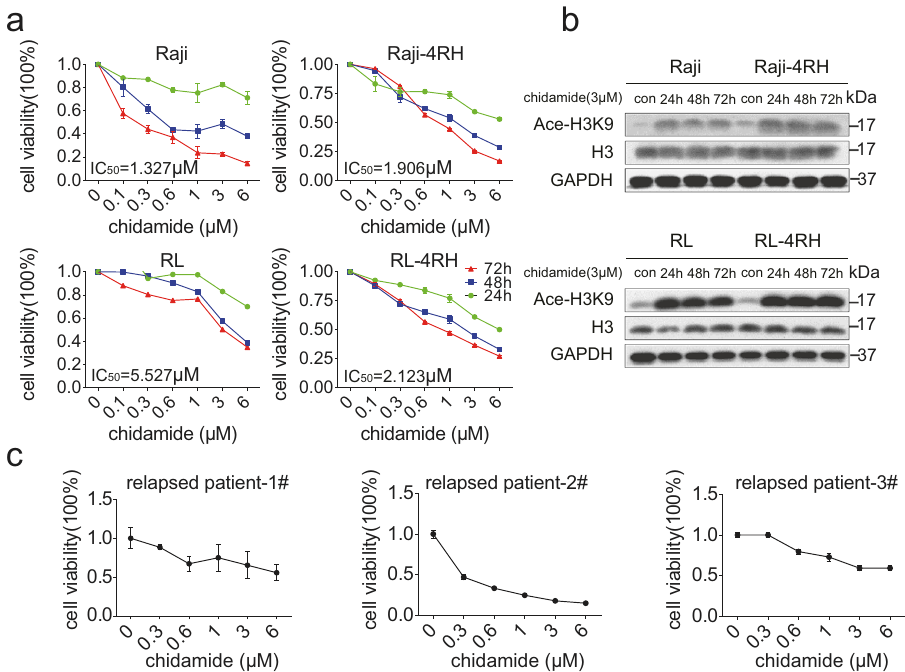
Fig. 1 Chidamide treatment reduced cell viability of RSCL, RRCL, and primary relapsed B-cell lymphoma cells. a Raji, Raji-4RH, RL, and RL- 4RH were treated with chidamide at different time points and concentrations. Cell viability were measured by using MTT assay, and IC50 of chidamide were calculated ( N = 3). b Acetylation of histone H3 lysine 9 (H3K9) was examined by using Western blot assay 24, 48 or 72 h after chidamide (3 μ M) treatment ( N = 3). c The primary relapsed B-cell lymphoma cells were treated with chidamide at different concentrations for 24 h (#1) or 72 h (#2 and #3). Cell viability was measured by using MTT assay ( N = 3). For all graphs, data are presented as mean ±